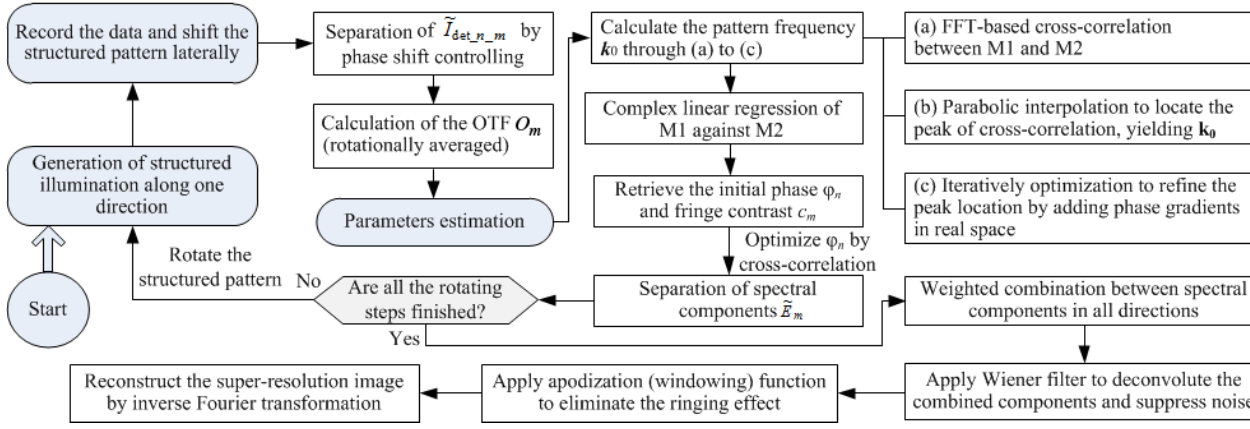
Fig. 8. Flowchart of image reconstruction process in